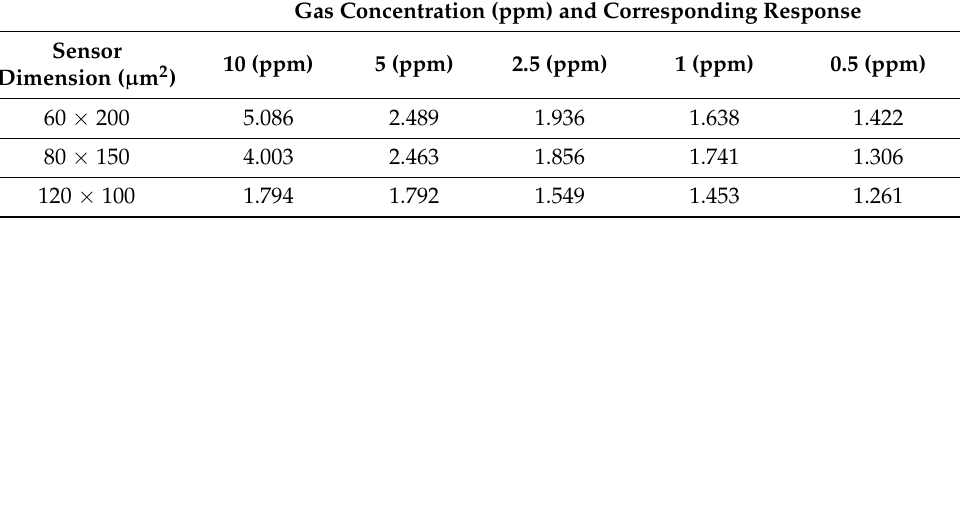
Table 1. Responses of the gas sensors with different gas injections.